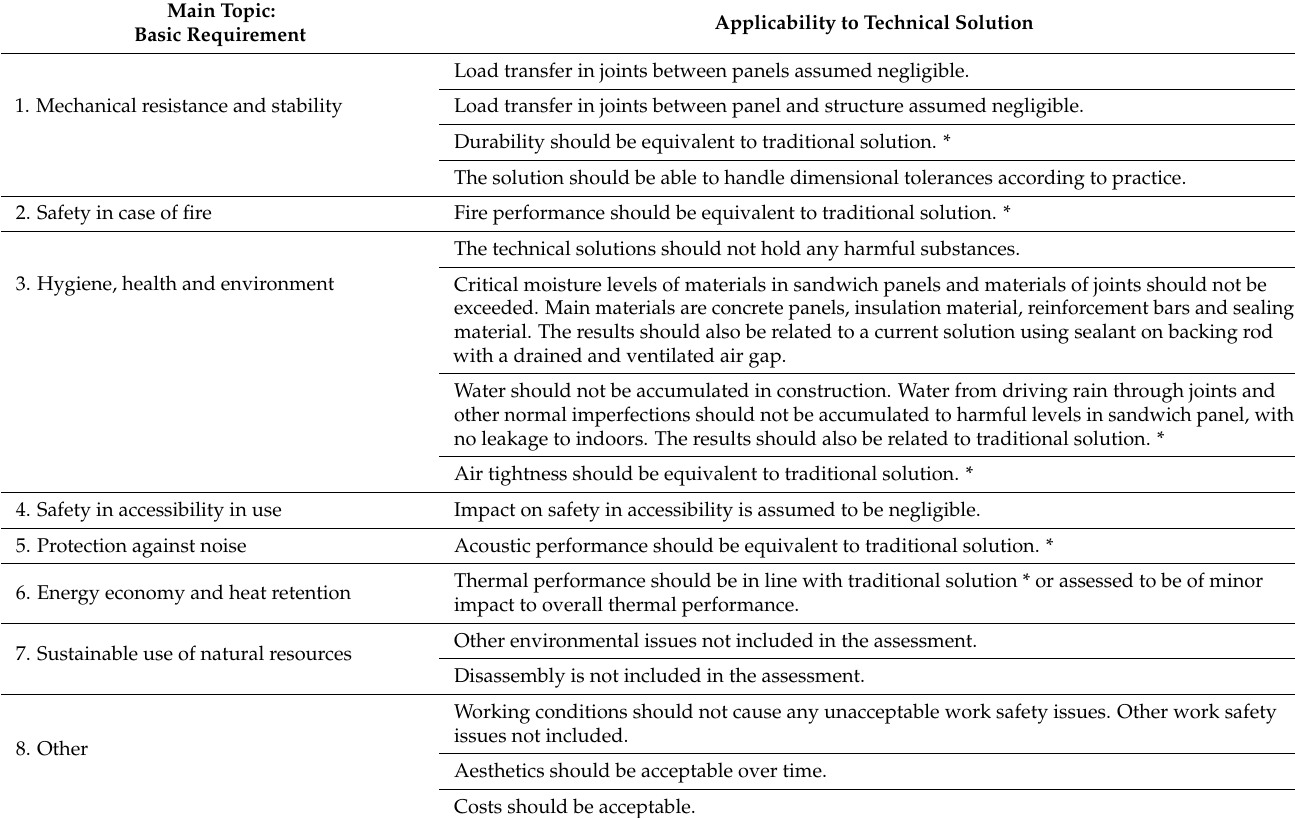
Table 2. The Initial definition of targets and early assumptions to be further elaborated. Main topics for basic requirements defined as in the Construction Products Regulation, Annex I